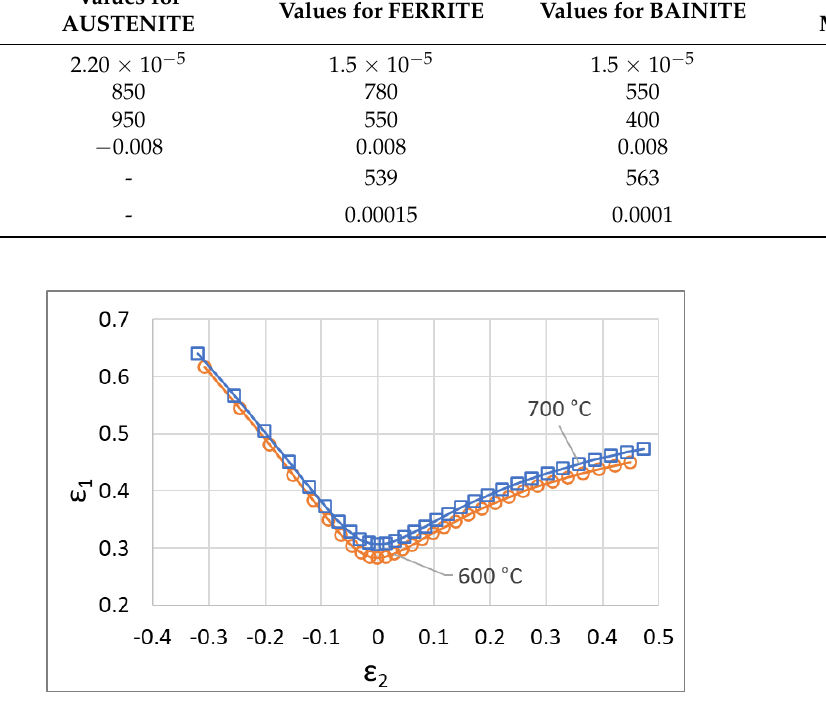
Figure 5. FLC for USIBOR ® 2000. Table 4. Thermal properties for USIBOR ® 1500.